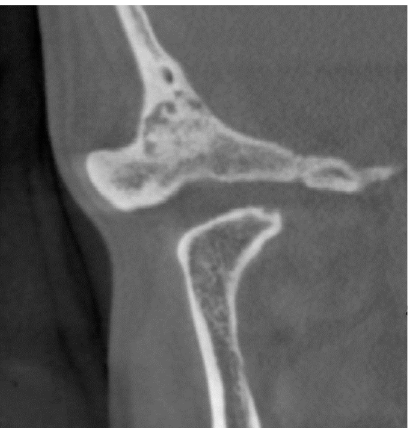
Figure 4. Imaging results in patient 1 after surgery. Cone-beam computed tomography. Eight years after surgery, there is no recurrence.